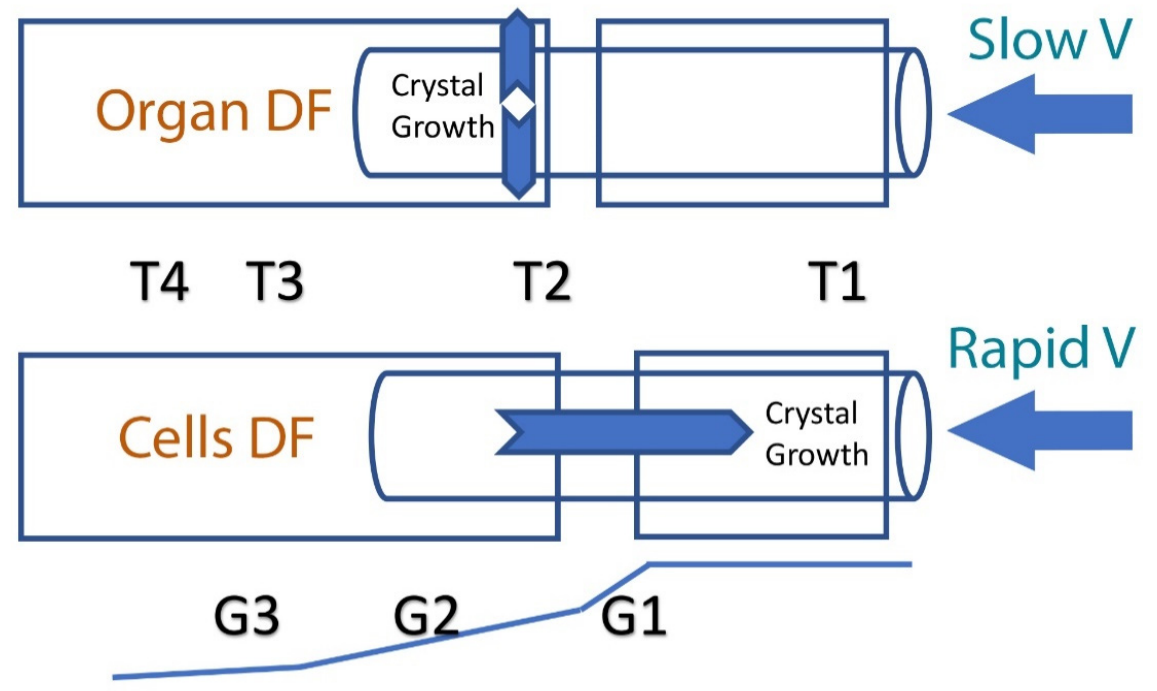
Figure 1. A schematic illustration of directional freezing of an organ and of cells. In the case of slow-velocity movement through the thermal gradients G1 and G2, heat transfer and ice crystal growth are perpendicular to movement. In cases of rapid velocity, heat transfer and ice crystal growth are in a direction opposite to that of the sample’s movement through the temperature gradient (G1). The cooling rate can be calculated according to this equation: B = G × V, where B is the cooling